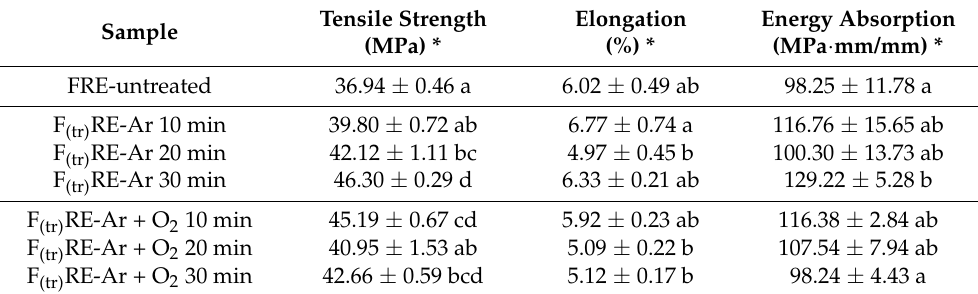
Table 6. Mechanical properties of untreated FRE and plasma-treated F (tr) RE composites.